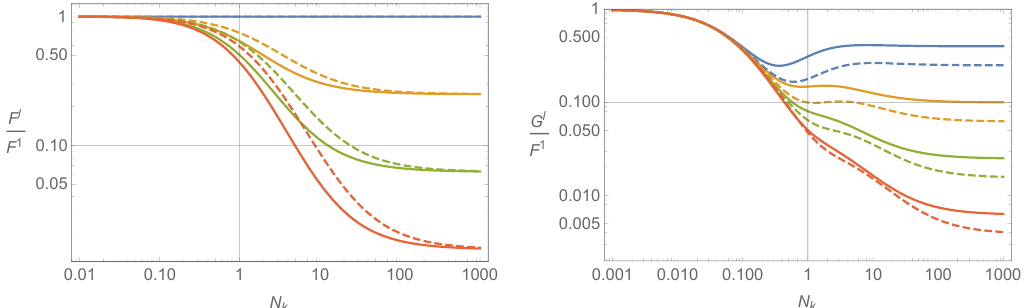
/F 1 (right) for l = 1 , 2 , 3 , 4 (from top to bottom) /F 1 (left) and G l 4 4 4 4